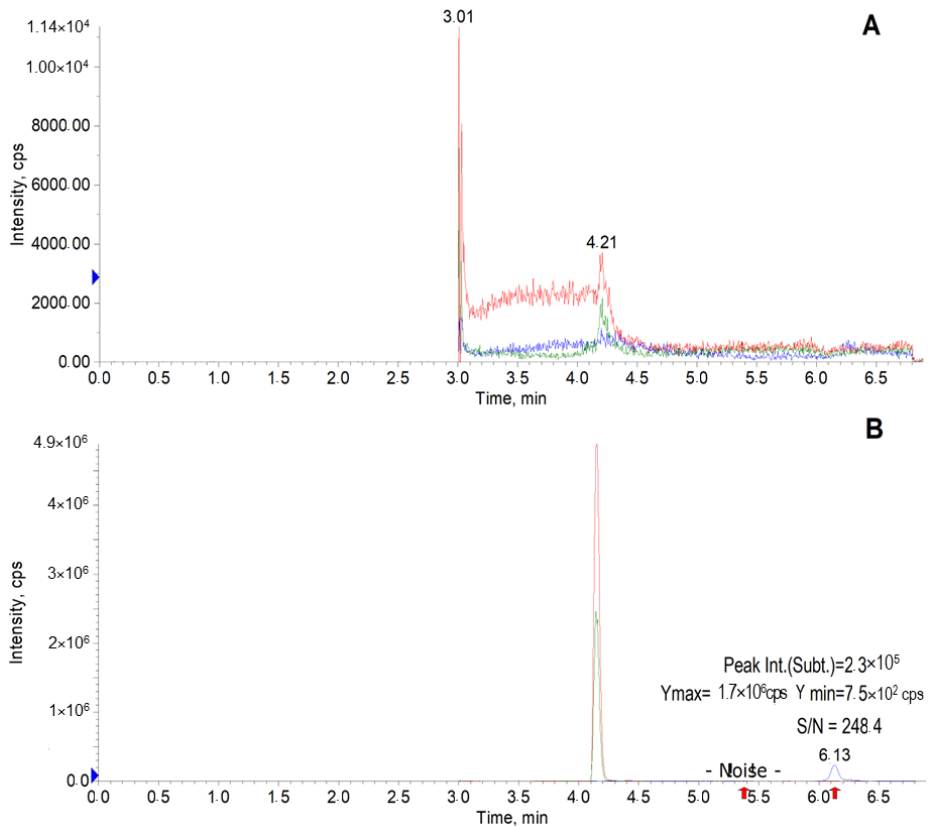
Figure 4. Chromatograms of a blank mice blood sample ( A ) and a mice blood sample containing K-142 at a concentration of 5 ng/mL ( B ).